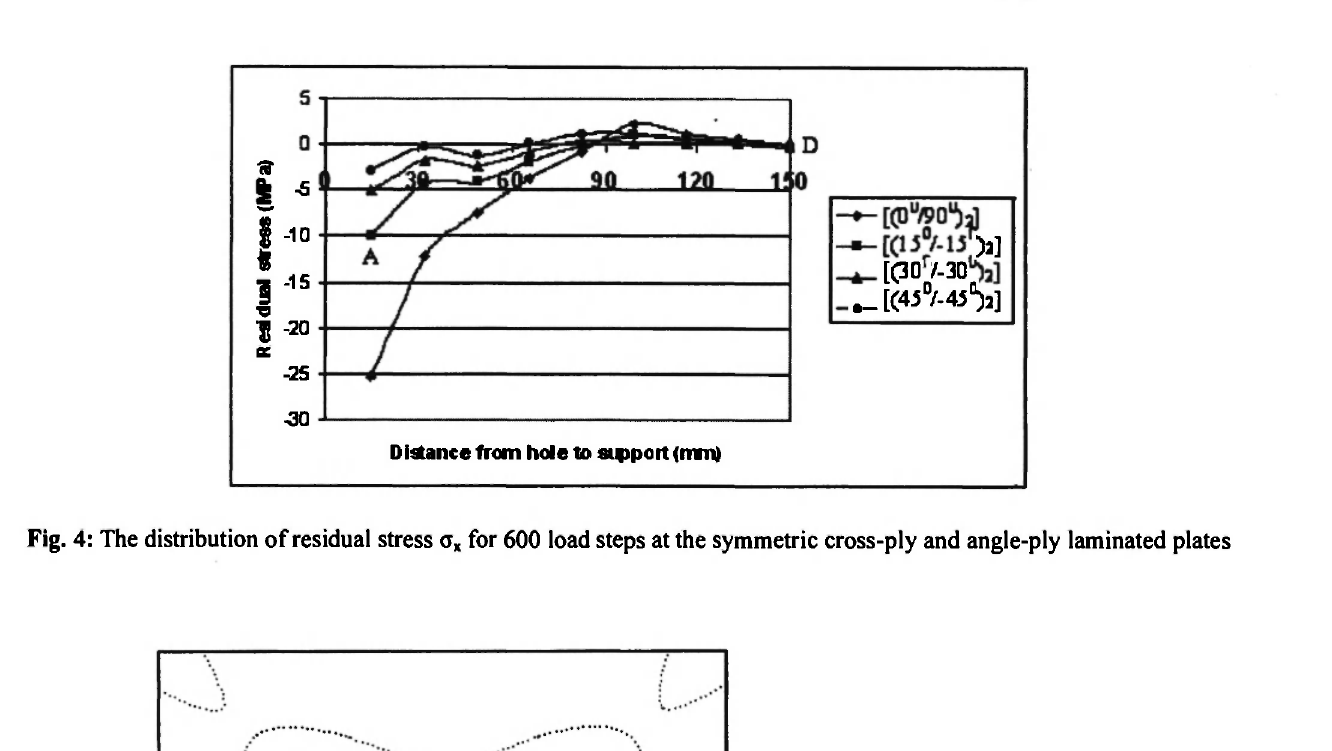
Fig. 5: Expansion of plastic zone for the symmetric angle-ply (15%15 0 ) 2 laminated plates